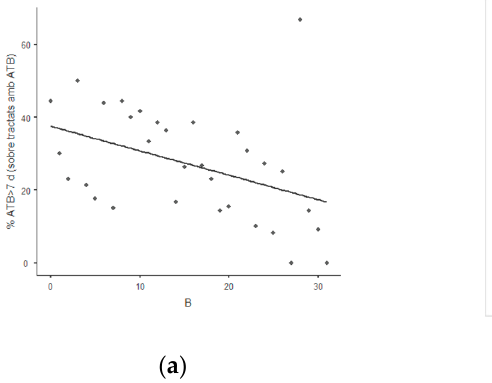
Figure 2. Evolution of the percentage of antibiotic treatments >7 days over patients treated with antibiotics in the Depart- ment of Surgery during the first 8 month-period (IP1) ( a) Scatterplot (rho = − 0.492); ( b ) Temporal evolution of the percent- age of patients on antibiotic treatment with duration over 7 days (R 2 = 0.172).